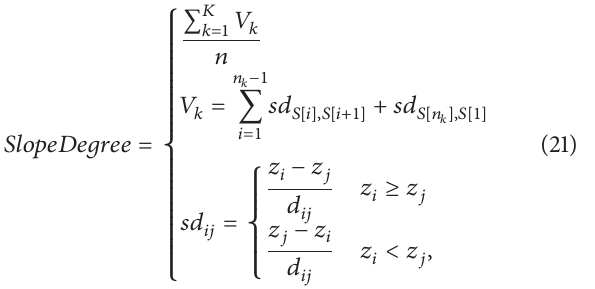
Figure 6, when 𝑆𝑙𝑜𝑝𝑒𝐷𝑒𝑔𝑟𝑒𝑒 = 7 %, the correlation